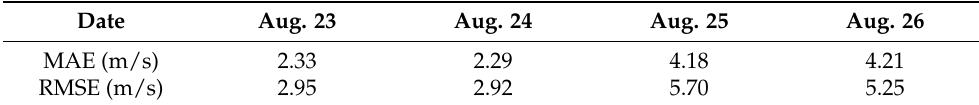
Table 3. CNN model daily data performance analysis results.